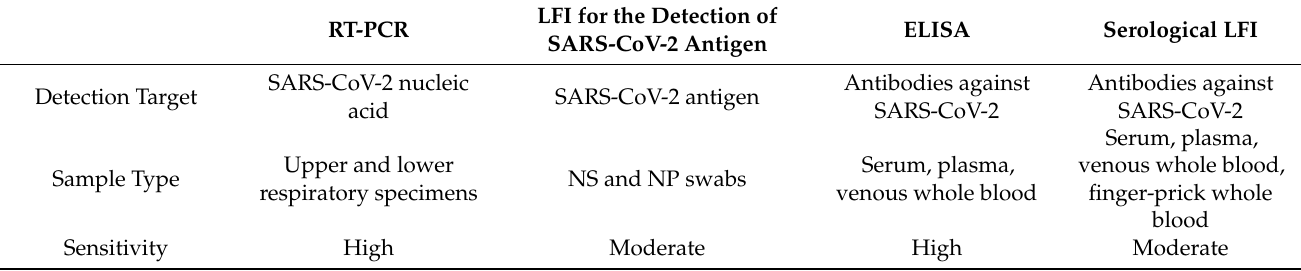
Table 1. An overview of differences between RT-PCR, LFI for the detection of SARS-CoV-2 antigen, ELISA and serological